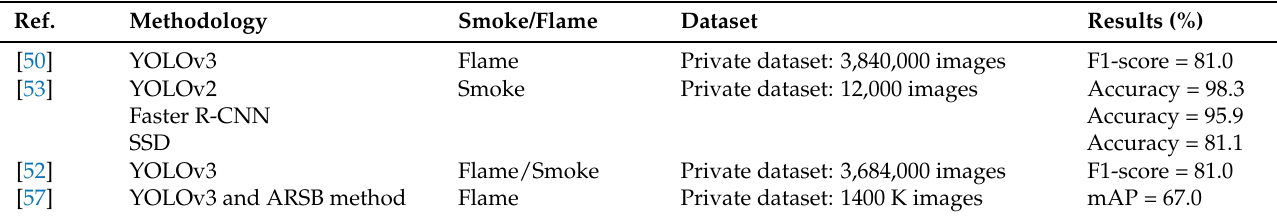
Table 2. Fire detection using Deep learning methods for